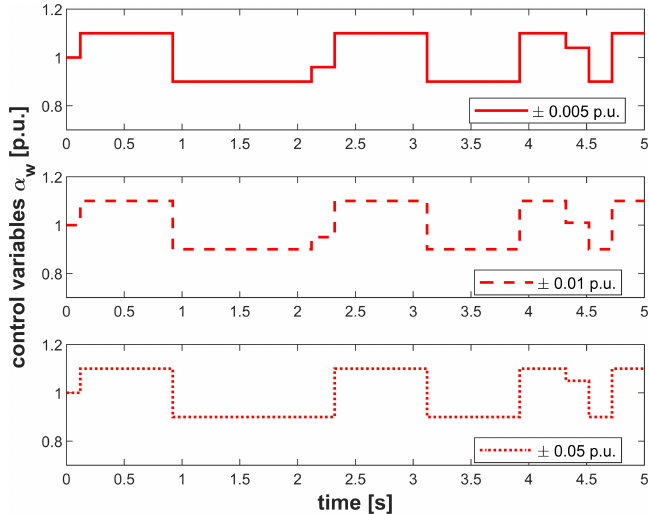
Figure 17. Control laws for the Villanova-Larino line with different control variable discretization